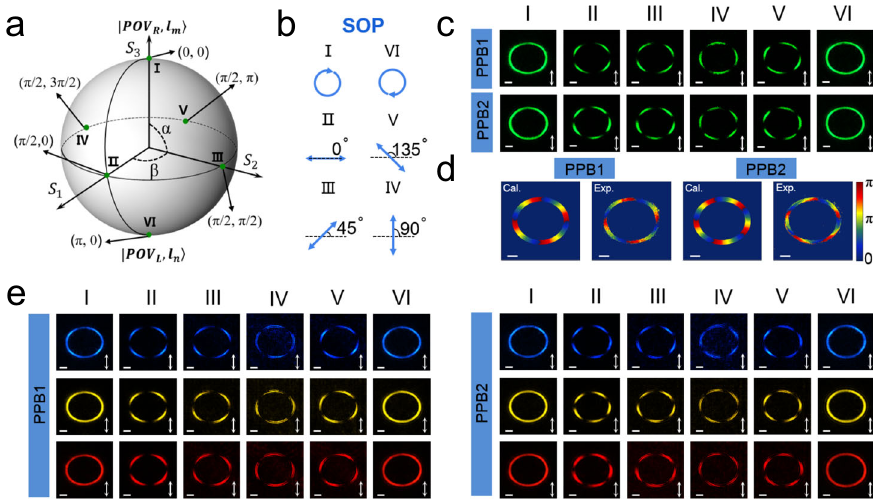
Fig. 4 Evolutions of the metasurface-generated PPBs corresponding to the points on HyOPS. a The selected six points on HyOPS representing six states of PPBs generated successively by metasurface. b Six states of polarization (SOP) of the light incident on the metasurfaces are chosen to generate various states of PPBs corresponding to the coordinates in ( a ). c The measured annular intensity patterns of the output states corresponding to the points in a for PPB1 and PPB2 in the x – y plane after transmission through a vertical linear polarizer depicted by the white double arrow. These images are captured at the designed focal position z = 200 μ m. Scale bar: 10 μ m. d The calculated and measured polarization orientations and distributions of PPB1 and PPB2 corresponding to point II in ( a ). Note that the horizontal polarization orientation is de fi ned as 0 rad. Scale bar: 10 μ m. e Measured annular intensity patterns of the PPB1 and PPB2 in the x – y plane at the wavelengths of 480 nm (blue), 580 nm (yellow) and 630 nm (red) at a propagation distance of z = 230, 195, and 180 μ m. These images are captured through a linear polarizer depicted by the white double arrow. Scale bar: 10 μ